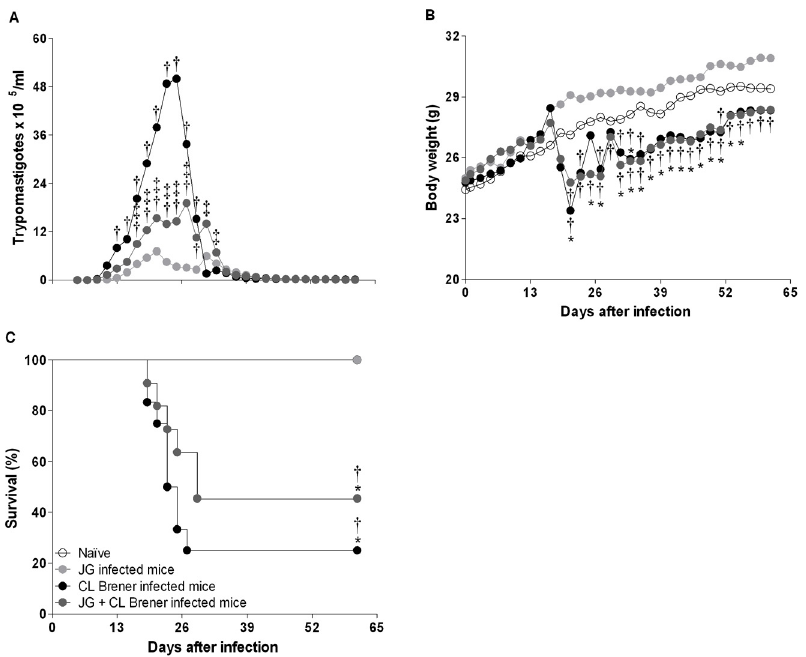
Figure 2. Assessment of the parasitemia, body weight and survival evolution. BALB/c mice were intraperitoneally infected with 100 trypomastigote forms of JG or CL Brener T. cruzi strains (single infection) or coinfected with 100 trypomastigotes of both T. cruzi populations in a 1:1 ratio and the parasitemia (A), body weight (B), and survival (C) were assessed at different days post infection. Parasitemia levels and body weight are expressed as the arithmetic mean of six or twelve mice per group (representative of two independent experiments). Symbols as follows: white circle: Naı¨ve mice; light gray circle: JG single infected mice; black circle: CL Brener single infected mice; and dark gray circle: JG and CL Brener coinfected mice. *, { and { represent P , 0.05 when compared with naı¨ve animals, JG single infected and CL Brener single infected mouse groups, respectively.